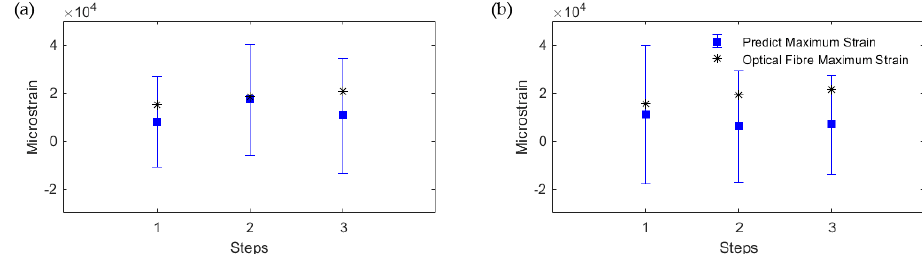
Figure 22. In-plane deformation Step 1 to Step 3: Predicted maximum strain with 95% of certainty along the horizontal line ( a ) at 180 mm and ( b ) at 320 mm vertically compared with optical fibre maximum strain measurements.